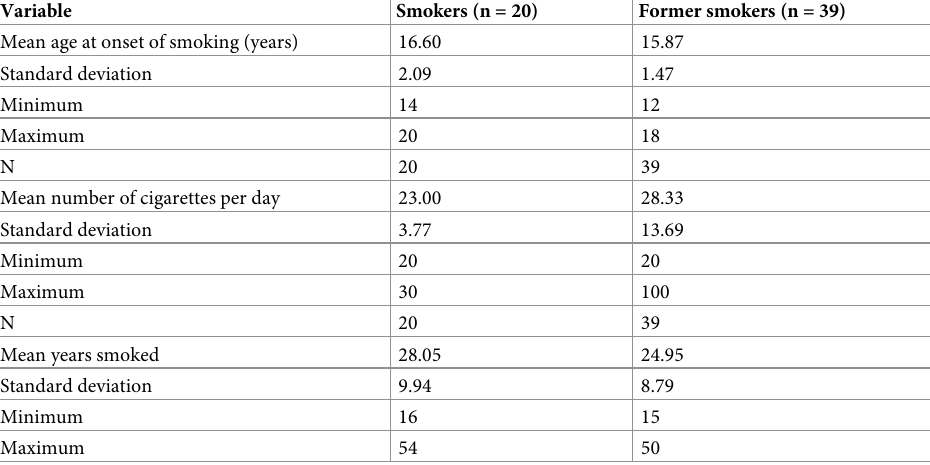
Table 2. Smoking behavior of